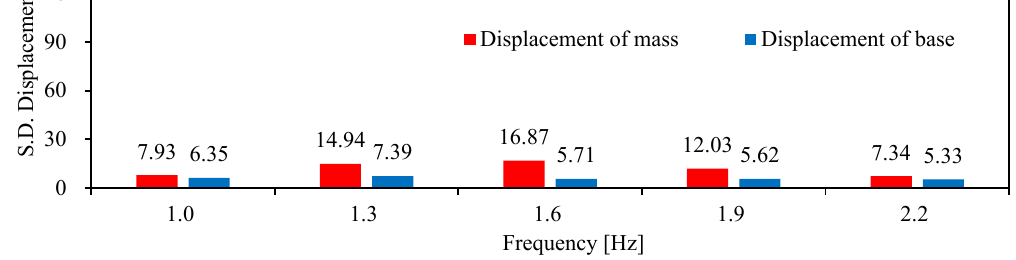
mass block peaked at approximately 1.6 Hz.